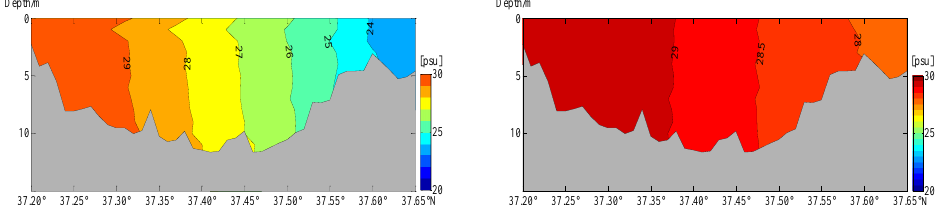
Figure 11. Salinity vertical distribution in Laizhou Bay during the wet season ( left ) and the dry season ( right ).